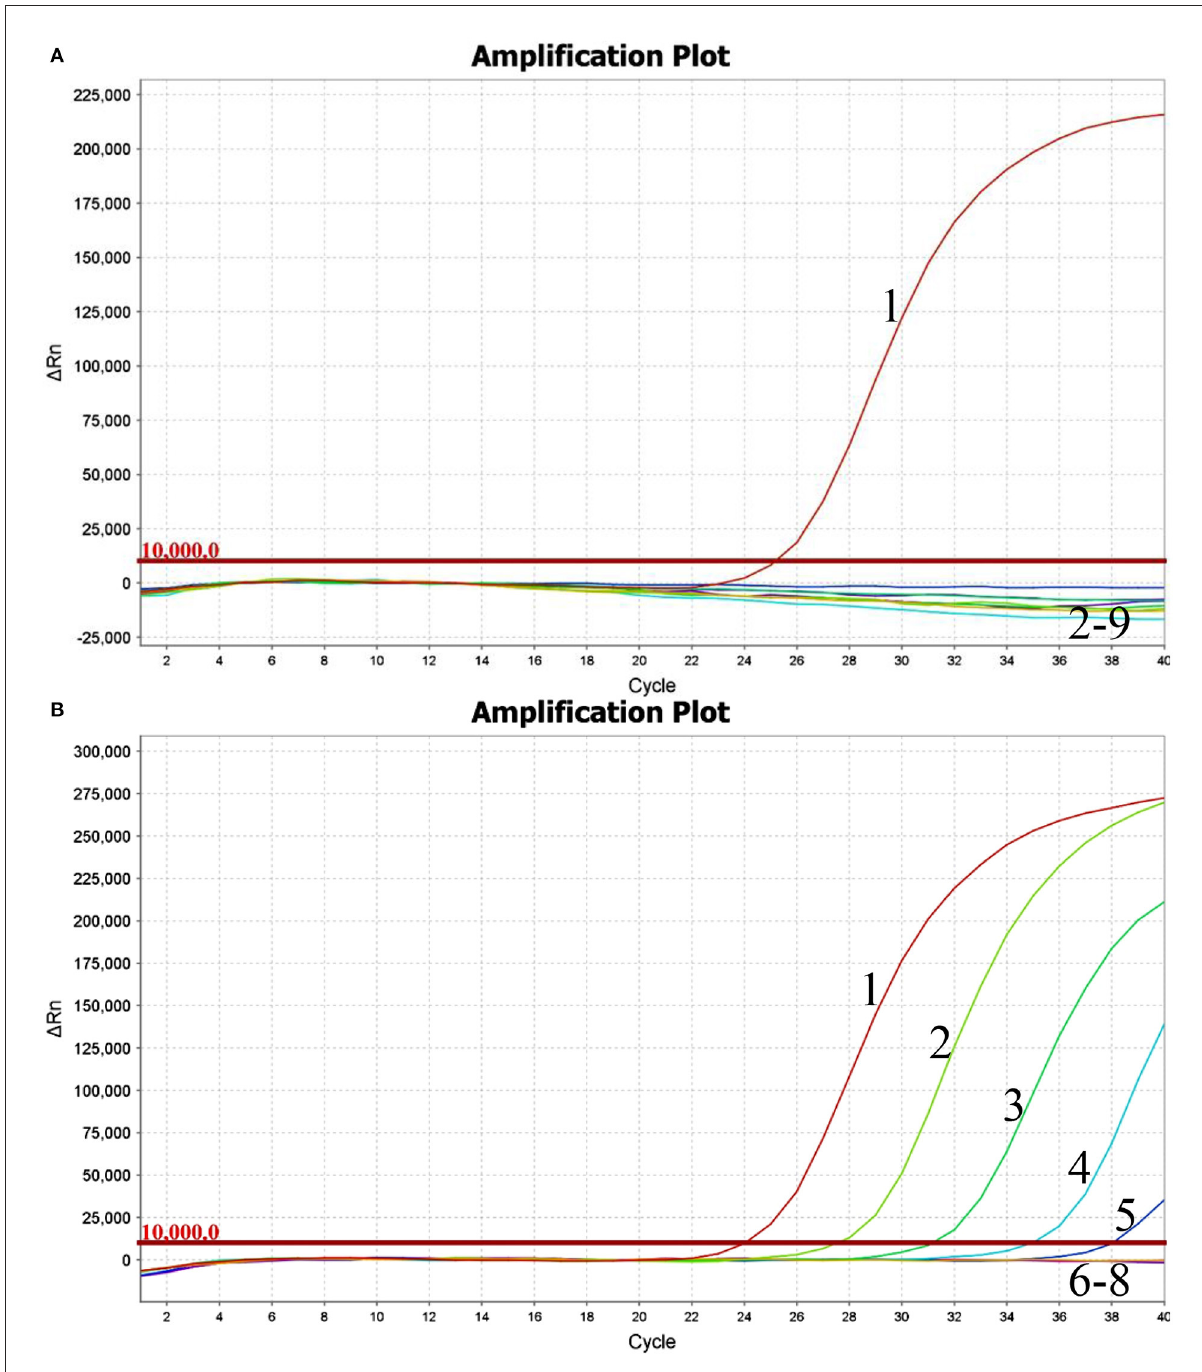
FIGURE1 Performance of BKV-specific real-time RT-PCR assay. Only the BKV RNA was amplified, and the limit of detection of the assay was 1.0 × 10 2 copies. (A) Analytical specificity of the real-time RT-PCR assay evaluating the common viruses causing diarrhea in cattle. Line 1, BKV; line 2, BRVA; line 3, BVDV; line 4, BCoV; line 5, BToV; line 6, BEV; line 7, BAdV 7; line 8, negative control; line 9, ddH 2 O. (B) Analytical sensitivity of the real-time RT-PCR assay using a dilution range of 1.0 × 10 6 -1.0 × 10 0 copies of BKV standard RNA. Line 1, 1.0 × 10 6 copies; line 2, 1.0 × 10 5 copies; line 3, 1.0 × 10 4 copies; line 4, 1.0 × 10 3 copies; line 5, 1.0 × 10 2 copies; line 6, 1.0 × 10 1 copies; line 7, 1.0 × 10 0 copies; line 8, ddH 2